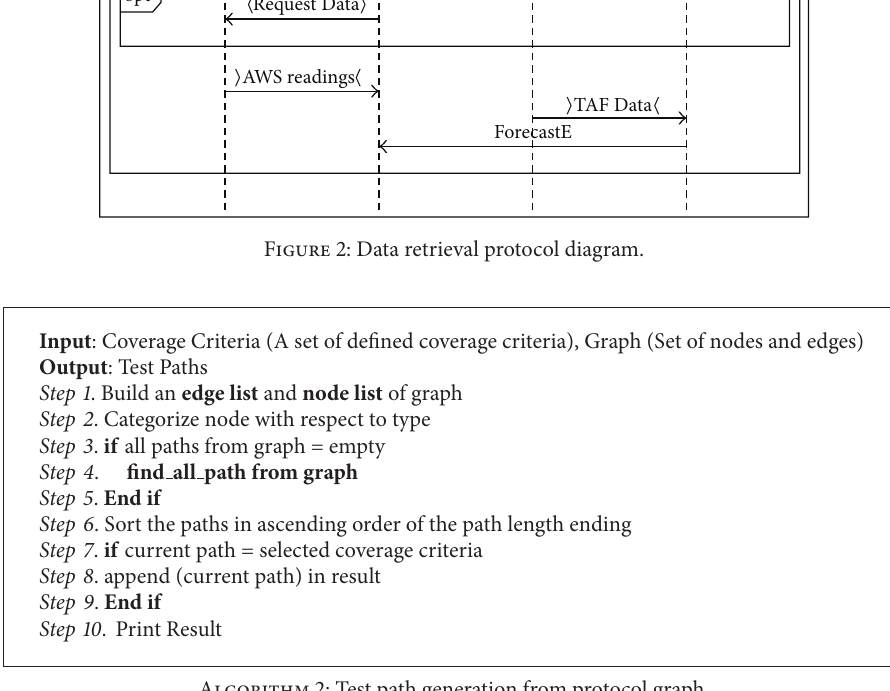
Algorithm 2: Test path generation from protocol